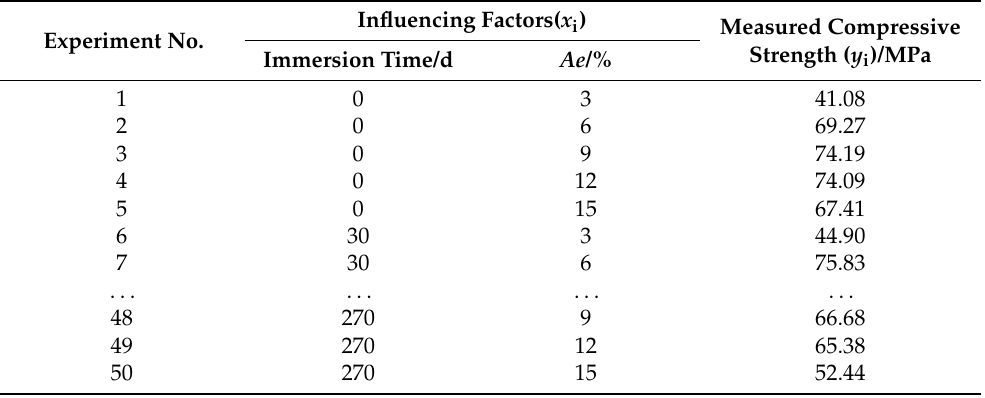
Table 6. Data for sample A.